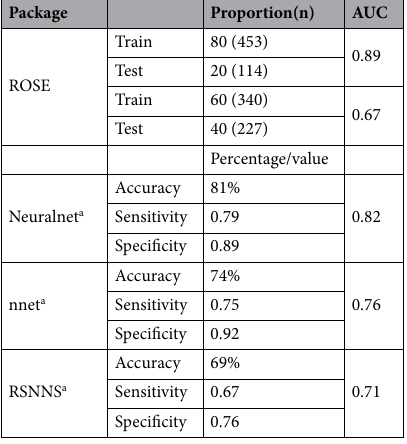
Table 2. Prediction scores and AUC of each neural network packages. a Data was divided into train : test =